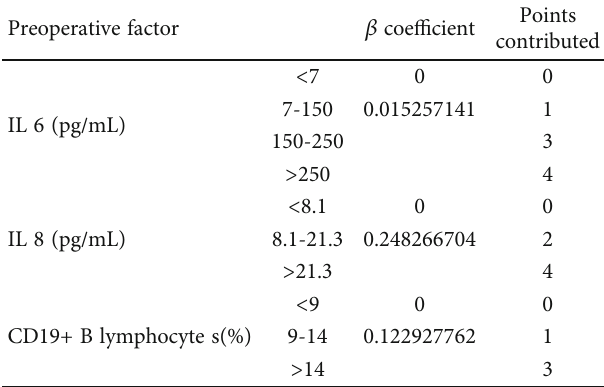
Table 1: Predictive scoring system for